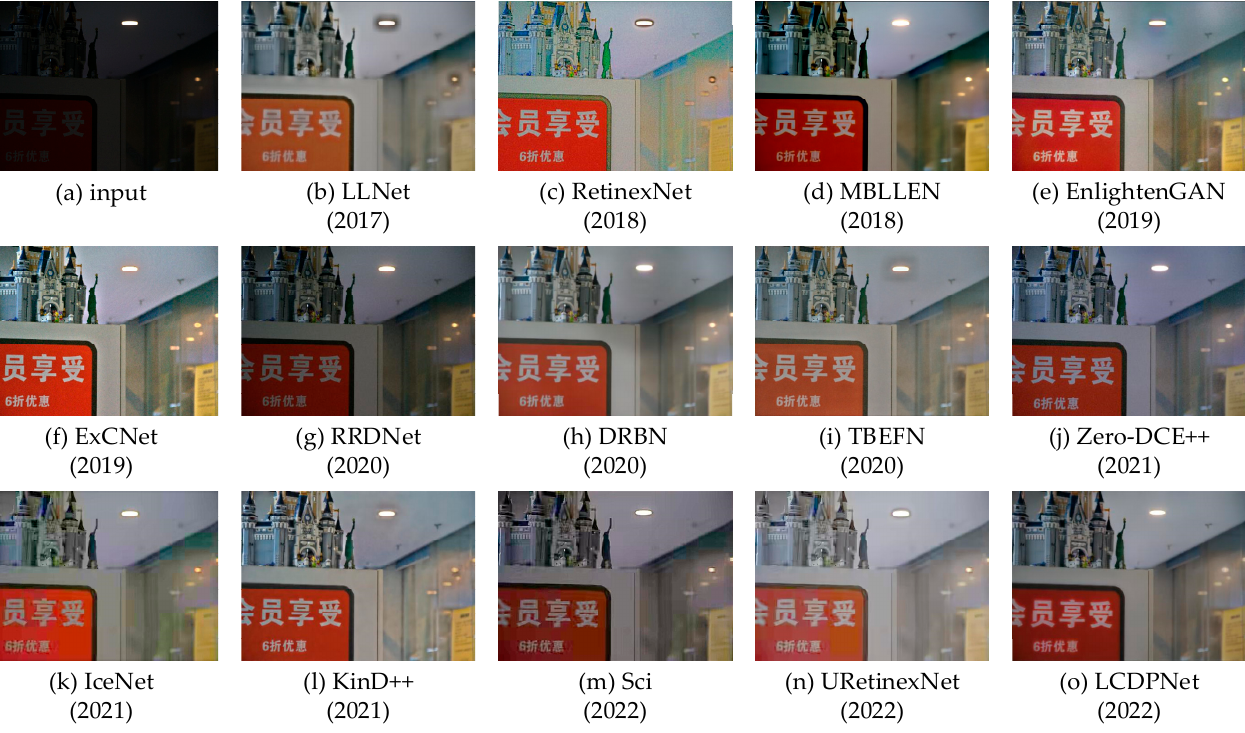
Figure 10. Visual results of different algorithms on low-illumination images sampled from the VE-LOL-L dataset.